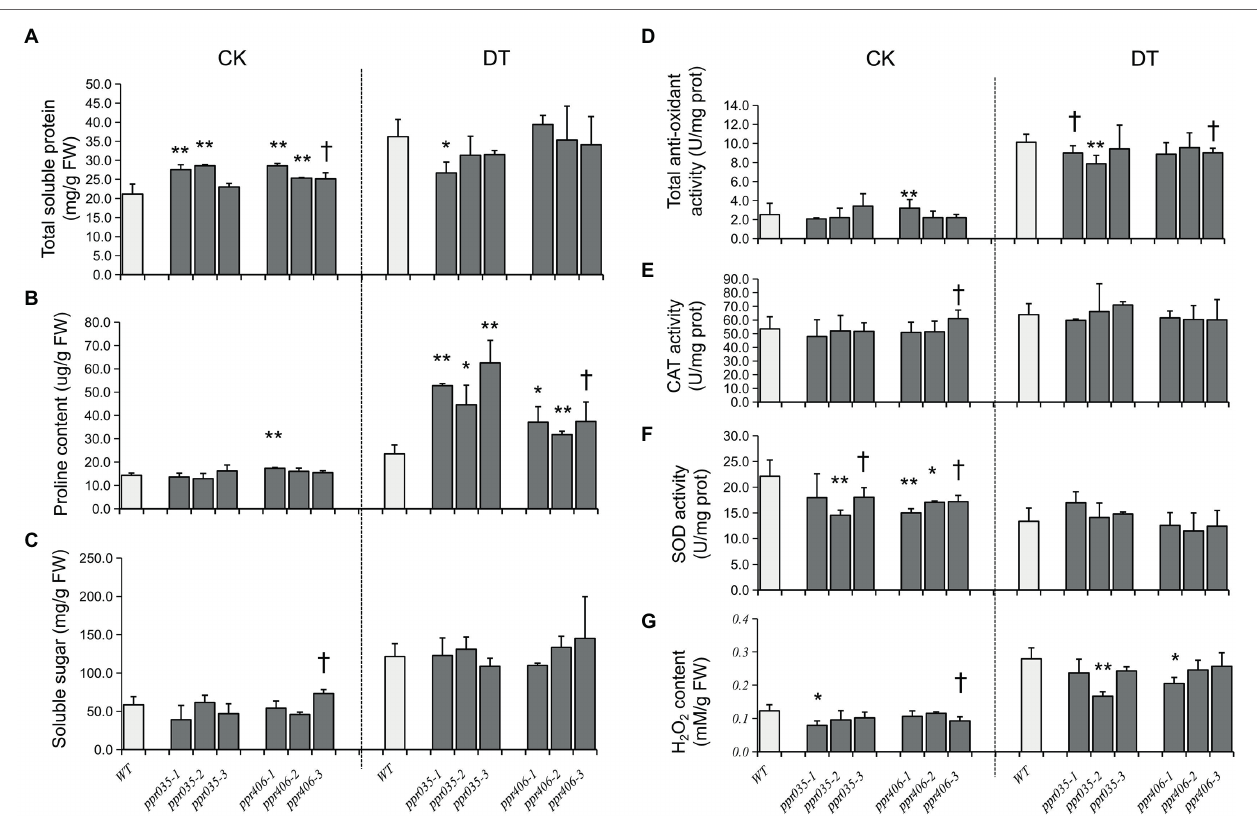
FIGURE 4 | Physiological traits measured from WT, ppr035 , and ppr406 in normal (CK) and PEG6000 simulated osmotic stress (DT). (A) Total soluble protein. (B) Proline content. (C) Soluble sugar. (D) total anti-oxidant capacity. (E) SOD activity. (F) CAT activity. (G) H 2 O 2 content. † , *, and ** indicate significances at p < 0.1, p < 0.05, and < 0.01 by independent t -test between WT and